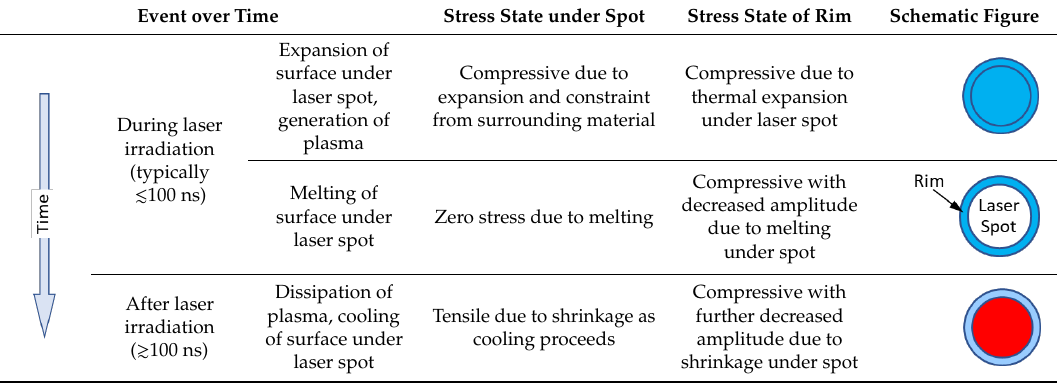
Table 1. Time evolution of the surface stress state of a laser-irradiated spot. Blue and red colors represent compression and tension, respectively.